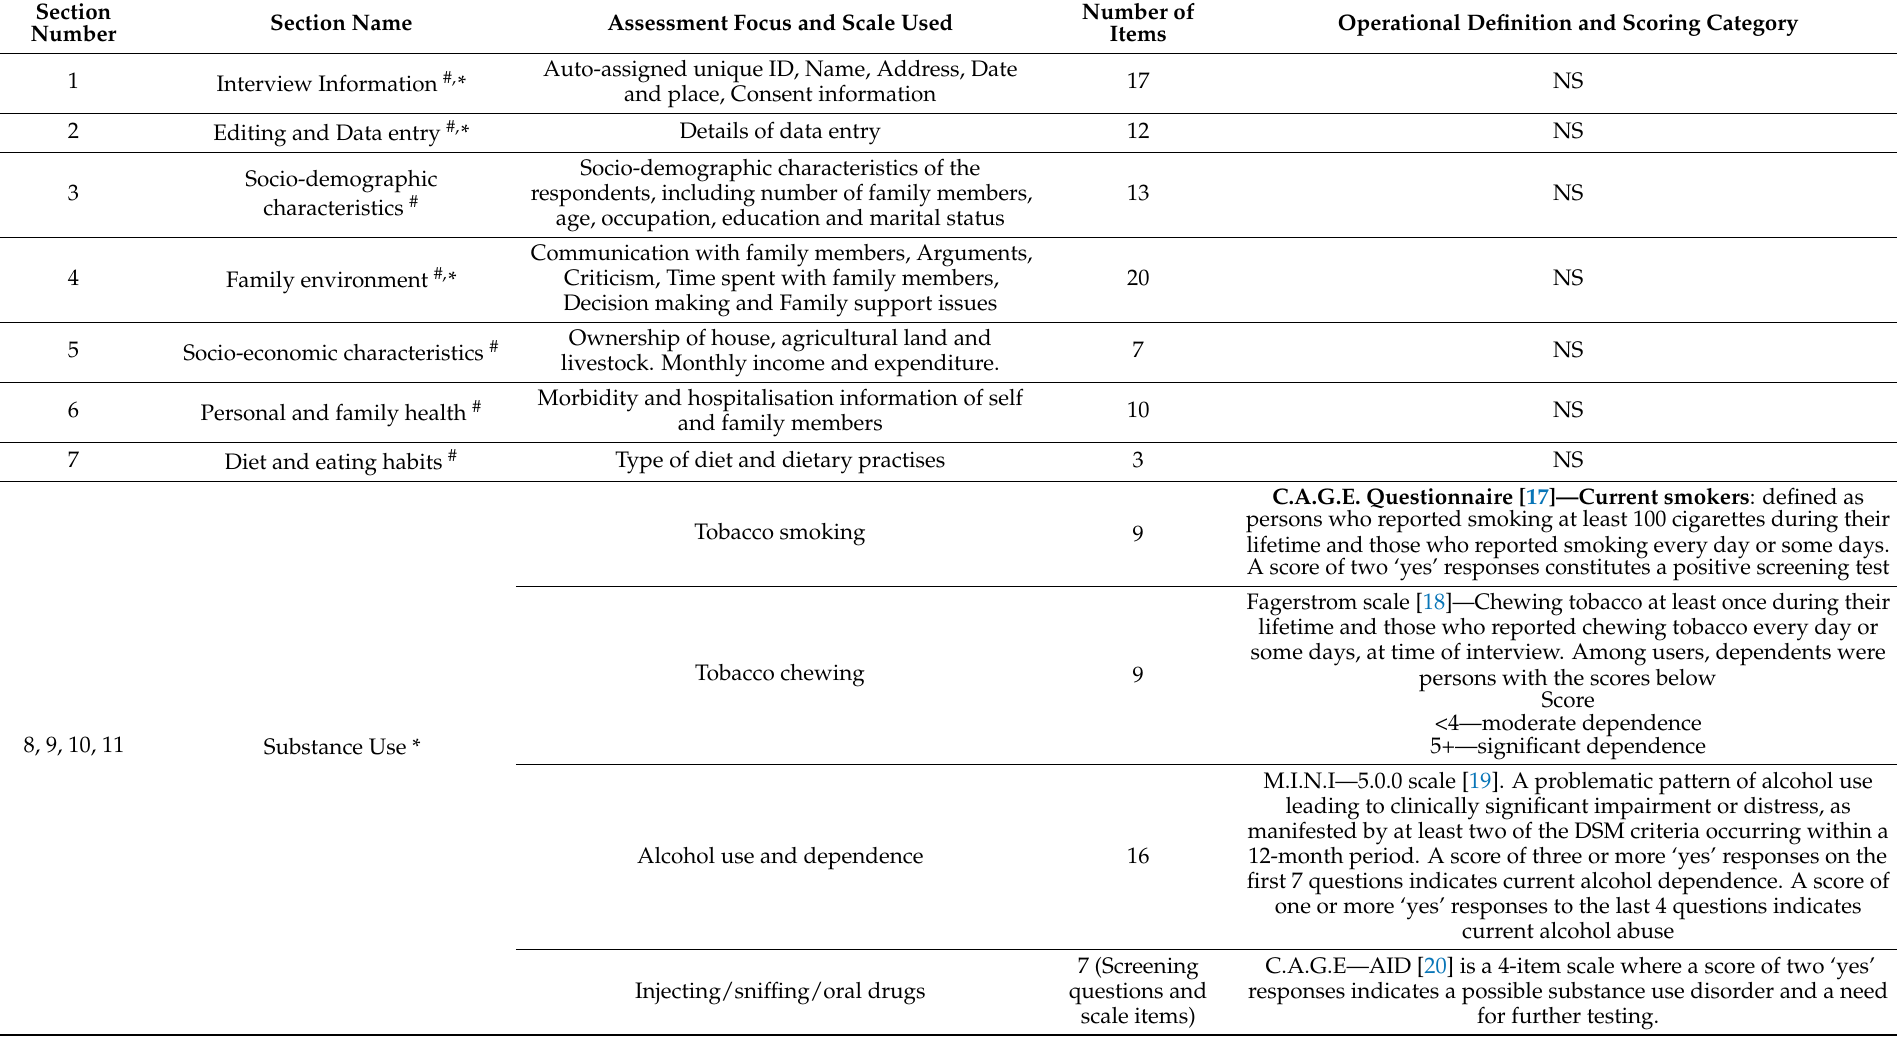
Table 1. Details of pre- and post-test questionnaire for assessment of life skills among participants attending the